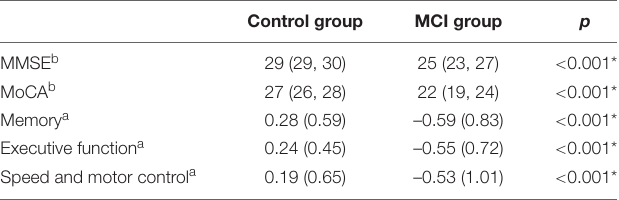
TABLE 2 | Comparison of cognitive function between two cognition groups after propensity score matching.